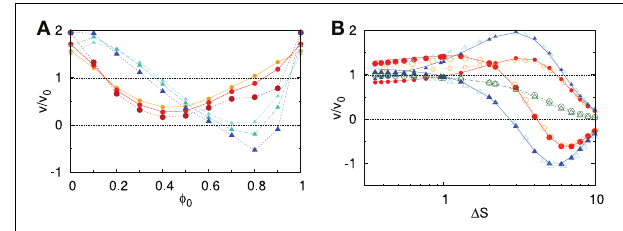
FIGURE 7 | Confinement modulated velocity for a processive (circles), non-processive (triangles) molecular motor moving in symmetric channel. (A) Normalized particle velocity, in units of v 0 = v ((cid:3) S = 0 ) as a function of the phase shift φ 0 for different values of the parameter (cid:3) S = 1 . 73 , 2 . 19 , 2 . 94 (the larger the symbol size, the larger (cid:3) S ), for (cid:3) V 1 = 0 . 2 and ω 2 , 1 / ω 1 , 2 = 0 . 01. (B) Normalized processive (circles), non-processive (triangles) molecular motor velocity, in units of v 0 , as a function of (cid:3) S and particle radius R (solid lines, with h 0 = 1 . 25 , h 1 = 0 . 2), h 0 (solid points, with R = 1 , h 1 = 0 . 2) or h 1 (open points, with R = 1 , h 0 = 1 . 25) for φ 0 = 0 . 1 , 0 . 9 (the larger the symbol size, the larger φ 0 ) for V 1 = 1 and ω 2 , 1 / ω 1 , 2 = 0 . 01. Green open circles (triangles) represent the average velocity of processive (non-processive) motors obtained by a uniform distribution of φ 0 as a function of (cid:3) S . Reprinted with permission from (59). Copyright (2013) by the American Physical Society.